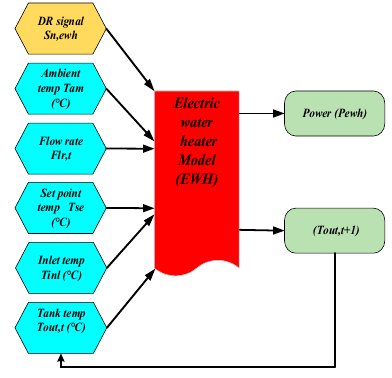
Figure 4. Flowchart of the electric water heater (EWH) load model. DR: demand response.